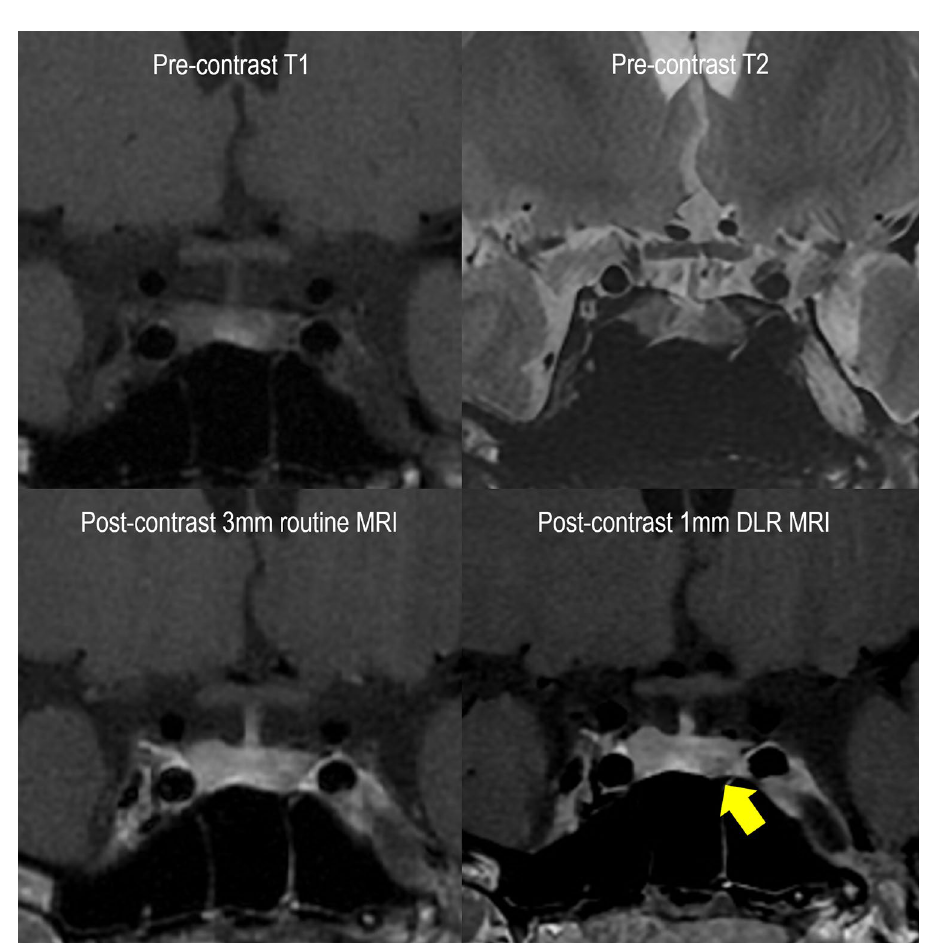
Figure 3. Representative case of newly detected pituitary microadenoma. A 19-year-old female patient had amenorrhea and underwent MRI as an initial evaluation. There is no grossly defined lesion on T2WI, T1WI, and 3 mm routine MRI. However, 1 mm DLR shows minute pituitary adenoma in the left inferior pituitary (arrow). MRI = magnetic resonance imaging, T2WI = T2-weighted image, T1WI = T1-weighted image, 3 mm routine MRI = 3 mm slice thickness MRI, 1 mm DLR = 1 mm slice thickness MRI with deep learning-based